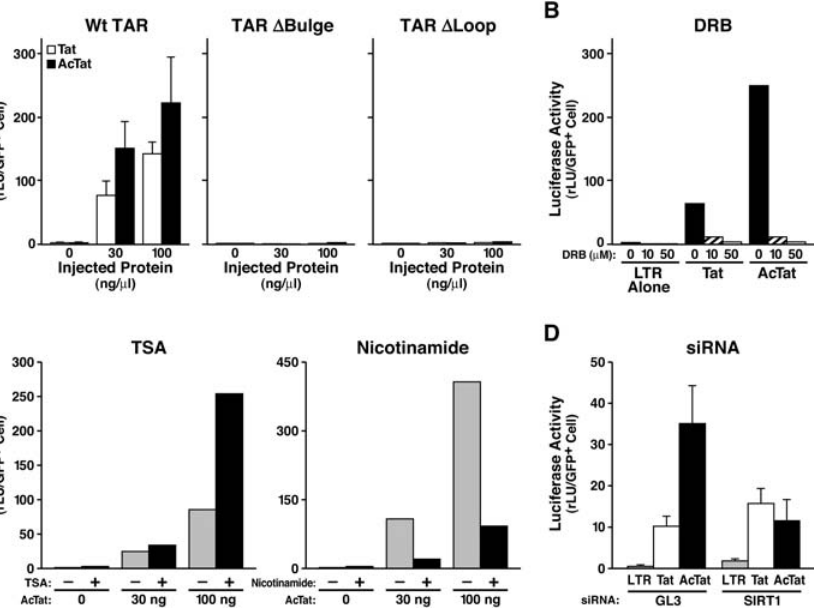
Figure 5. Transcriptional Activity of AcTat Depends on Deacetylation by SIRT1 (A) AcTat functions through TAR and cyclinT1 binding. Nuclear microinjection of increasing amounts of synthetic Tat or AcTat together with wild-type (wt TAR), TAR D bulge, or TAR D loop mutant HIV LTR luciferase constructs into HeLa cells. Cells were coinjected with CMV-GFP, and luciferase activity was calculated per GFP-positive cell. An average of three experiments is shown ( 6 SEM). (B) AcTat transactivation requires CDK9. HeLa cells microinjected with Tat or AcTat (each 30 ng/ l l) and the HIV LTR luciferase reporter were treated with increasing amounts of DRB, a known CDK9 inhibitor, for 4 h. (C) AcTat transcriptional activity is inhibited by nicotinamide, but not TSA. HeLa cells injected with HIV LTR luciferase and increasing amounts of AcTat were treated with TSA (400 nM) or nicotinamide (5 mM) for 4 h. The average of two experiments is shown. (D) SIRT1 is necessary for AcTat, but not Tat function. HeLa cells were transfected with siRNAs specific for SIRT1 or GL3 control siRNAs 48 h before microinjection of HIV LTR luciferase and Tat or AcTat (each 30 ng/ l l). The average of three experiments is shown ( 6 SEM). DOI: 10.1371/journal.pbio.0030041.g005 PLoS Biology |